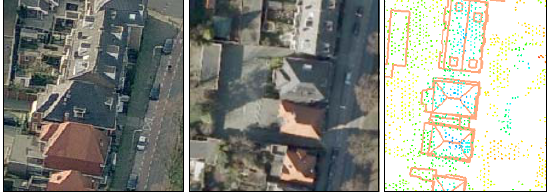
Figure 6. Portions of an oblique image ©Blom of the city centre of Enschede, a nadir looking image from UltracamD and a point cloud obtained from oblique images overlaid with 3D